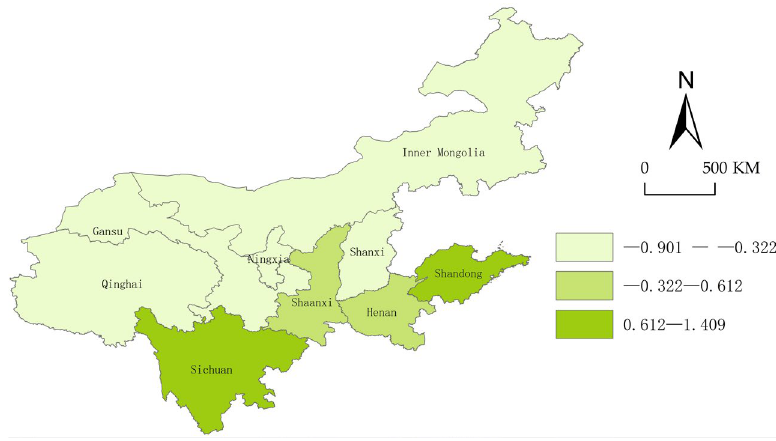
Figure 5. Security landscape of the Yellow River Basin (2015).